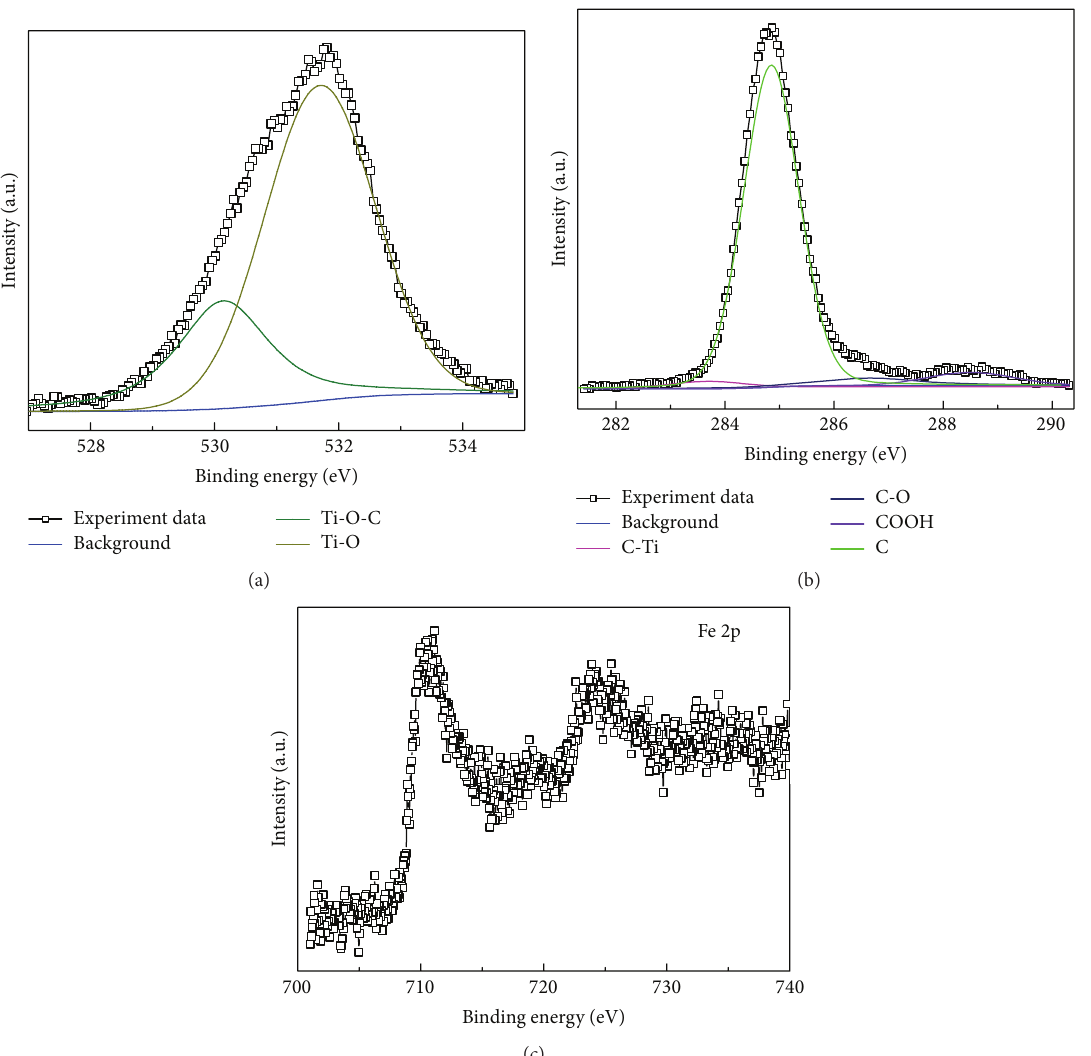
Figure 2: XPS of core level signals of (a) O1s, (b) C 1s, and (c) Fe 2p of the Fe-C codoped TiO 2